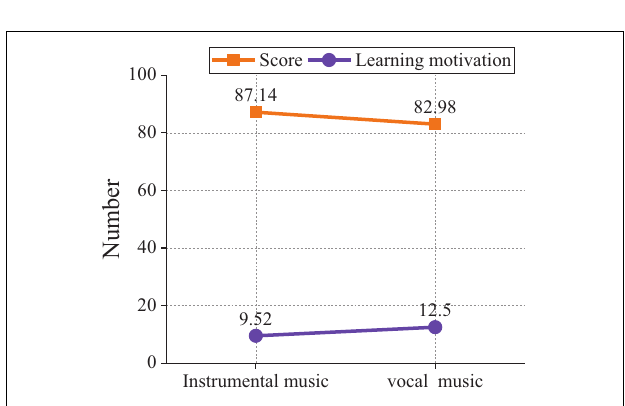
FIGURE 6 | Results of college students’ preference for music classroom model.